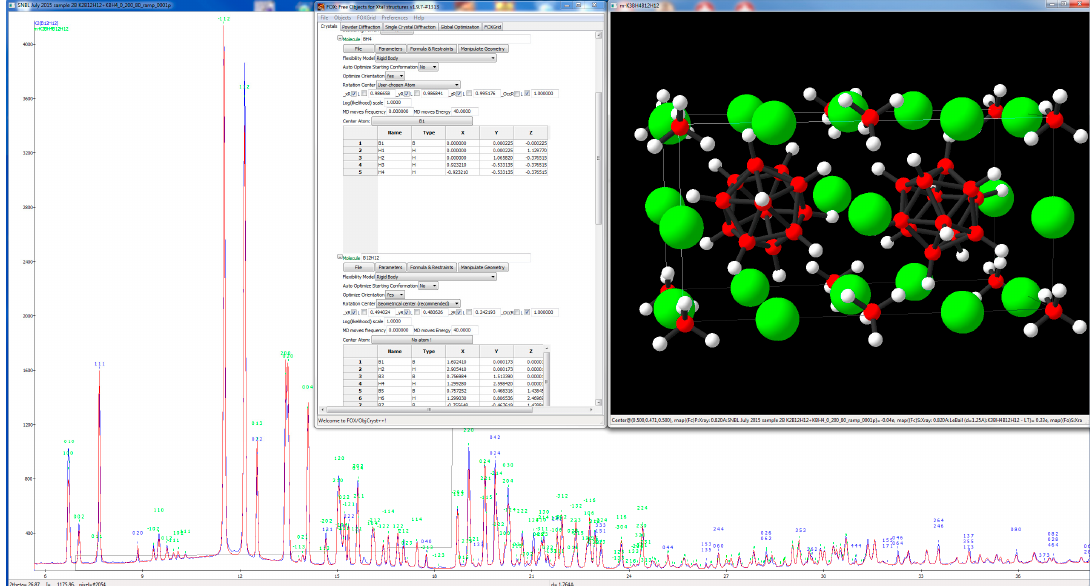
Figure 4. Monoclinic K 3 BH 4 B 12 H 12 , an example of an inorganic structure ( P 2/ c , a = 7.0497(2), b = 6.9917(2), c = 13.4192(3) Å, β = 94.508(1) ◦ at RT) with rigid complex anions BH 4 − and B 12 H 12 2 − [32]. Synchrotron powder diffraction data (SNBL at the ESRF Grenoble, λ = 0.81984 Å), K 3 BH 4 B 12 H 12 (peaks labelled in green), unreacted K 2 B 12 H 12 (peaks labelled in blue), potassium (green), boron (red), hydrogen (white).